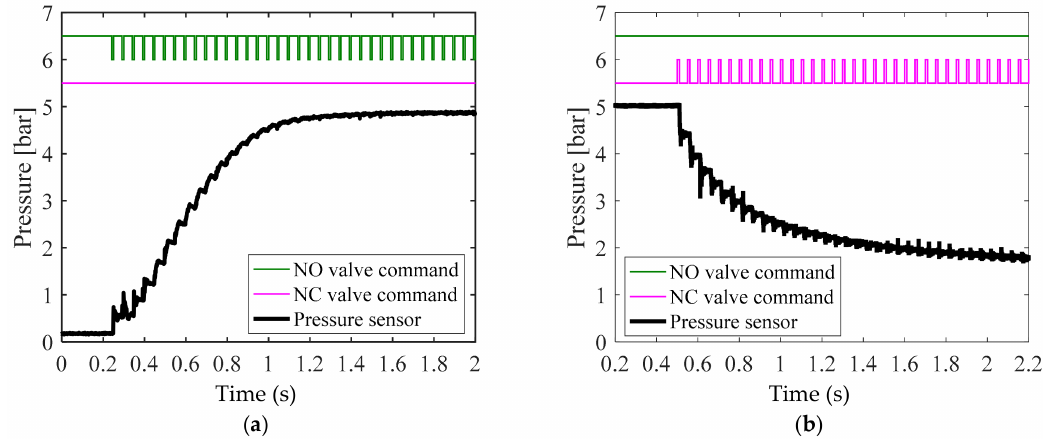
Figure 5. Experimental results for pneumatic valve’s response tests for the ( a ) apply mode test with 20% pulse-width modulation (PWM) duty ratio, and ( b ) dump mode test with 20% PWM duty